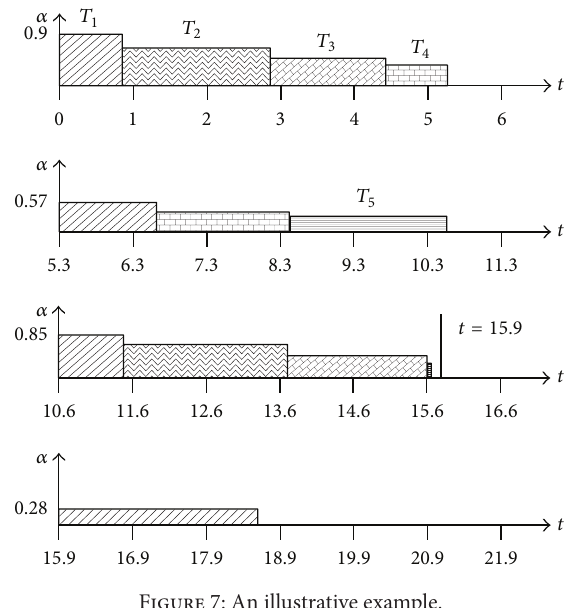
Figure 7: An illustrative